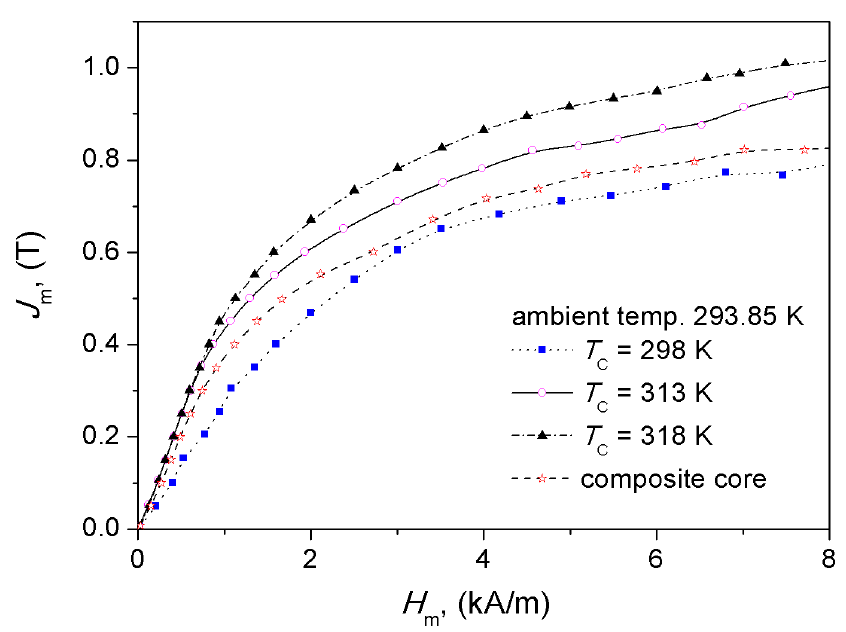
Figure 6. The measured J m vs. H m curves of the examined composite core and its components at room temperature.